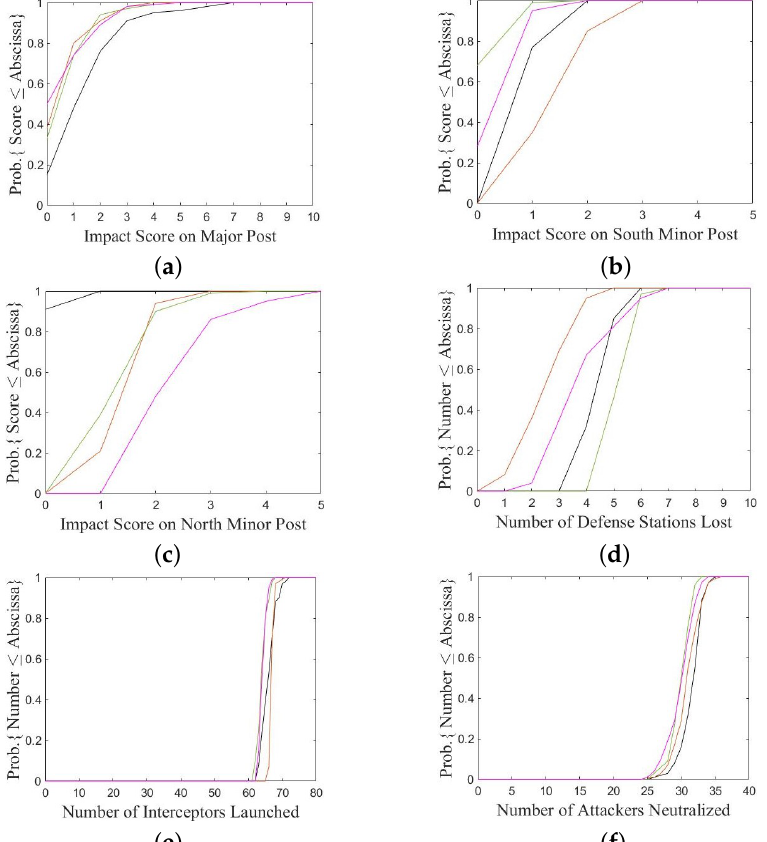
Figure 11. CDF of ( a ) impact score on major post; ( b ) impact score on south post; ( c ) impact score on north post; ( d ) number of lost defense stations; ( e ) number of launched interceptors; ( f ) number of lost attackers, against pincer attack formation, black: ζ 1 , orange: ζ 2 ,green: ζ 3 , purple: ζ 4